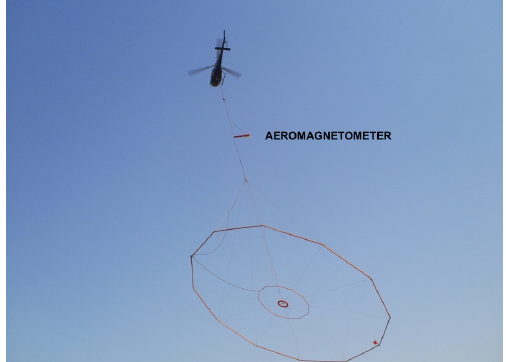
Figure 4. Model of a B2 Helibras aircraft with a sensor bird and VTEM antenna (source: S. Guimarães, author private collection, June 2008).